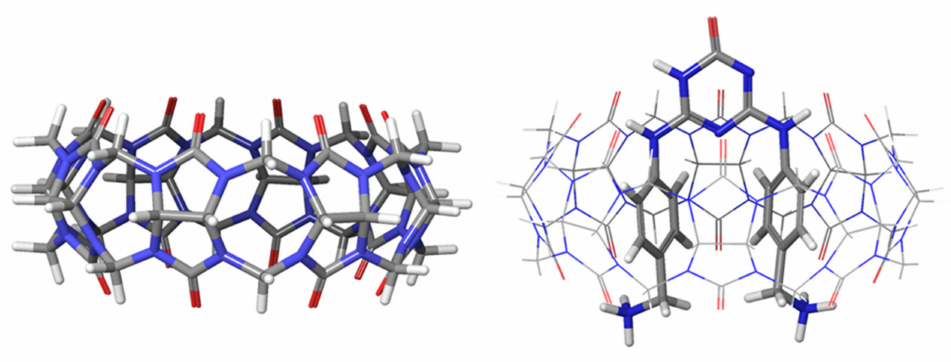
Figure 1. Structure of the host molecule CB[8] (side view) and co-crystallized with G0